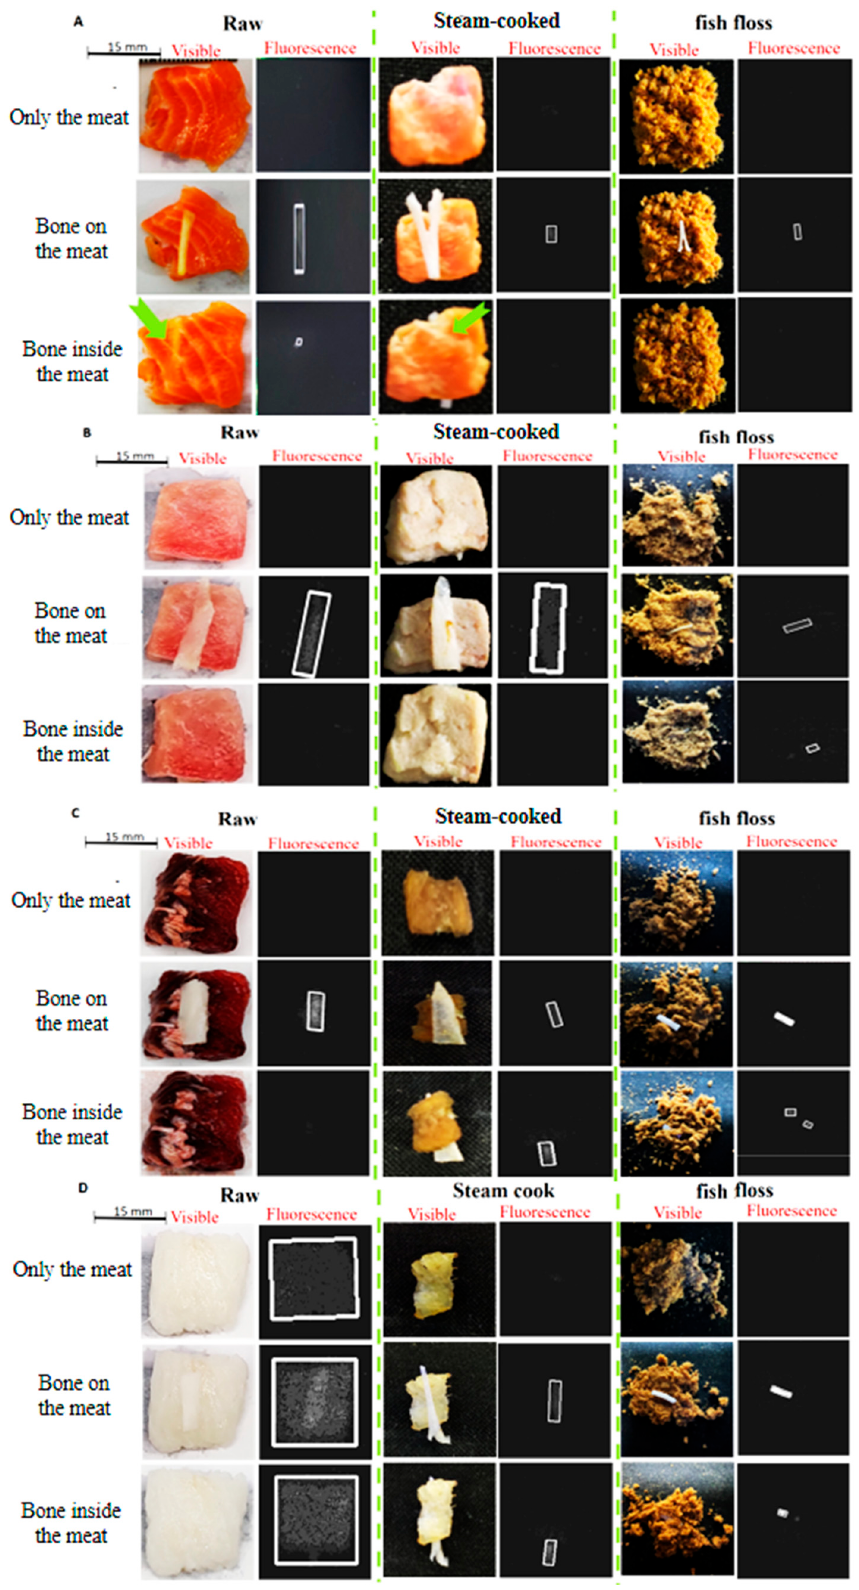
Figure 7. Visible and fluorescence images of fish meat and its bone under different cooking conditions (raw meat, steam-cooked meat, and fish floss) and arrangements (meat only and a fish bone over or inside its meat or fish floss). The four fish types were ( A ) swordfish, ( B ) salmon, ( C ) tuna, and ( D ) cod.